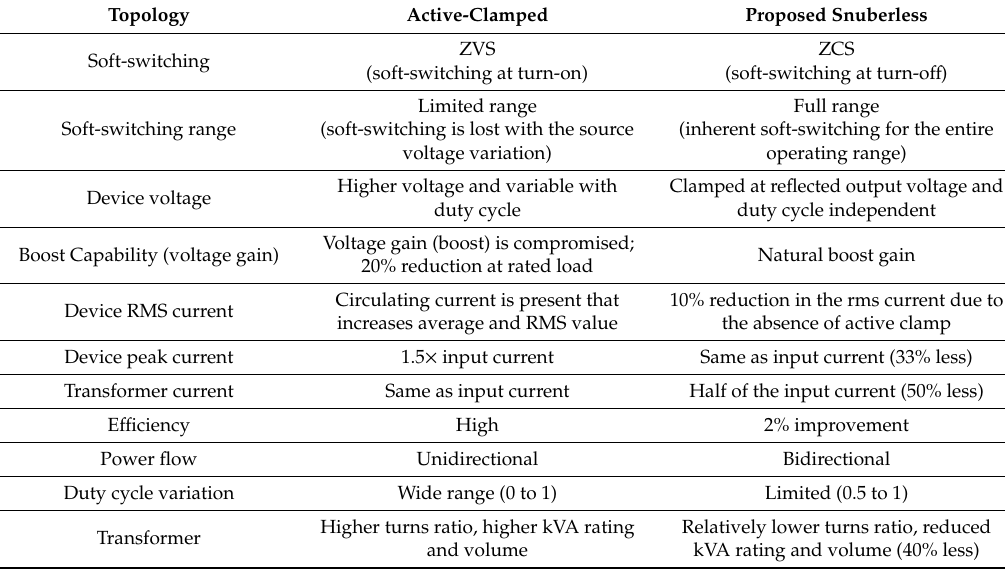
Table 3. Comparison of proposed snubberless topology with active-clamped topology. Table 3 Comparison of proposed snubberless topology with active-clamped topology. Topology